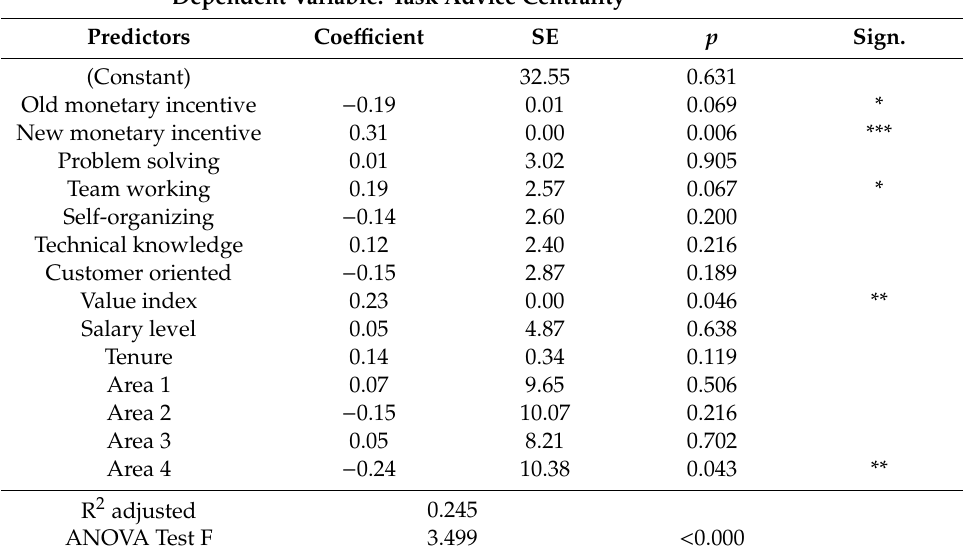
Table 4. First detection (year